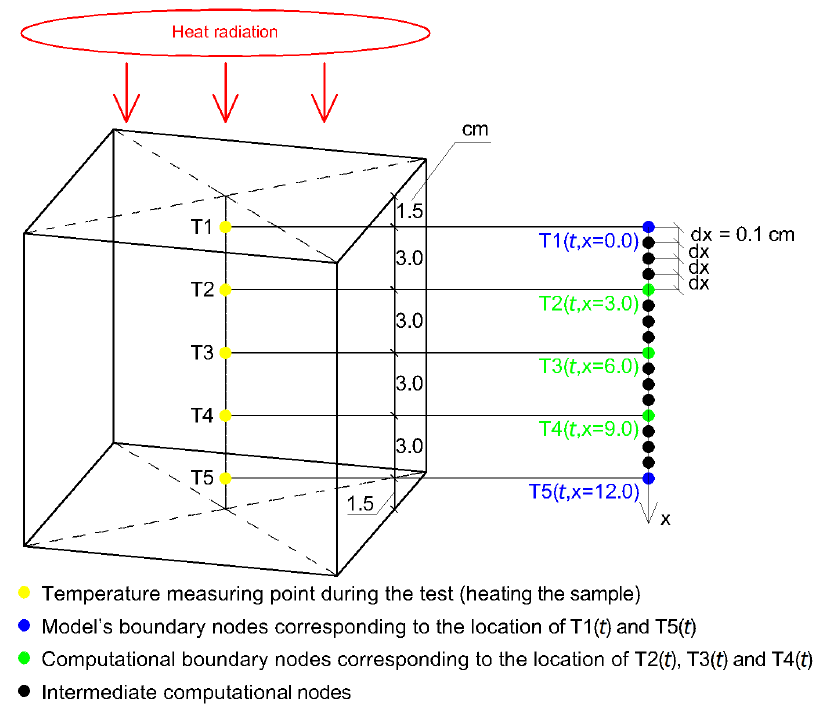
Figure 8. Schematic of the numerical